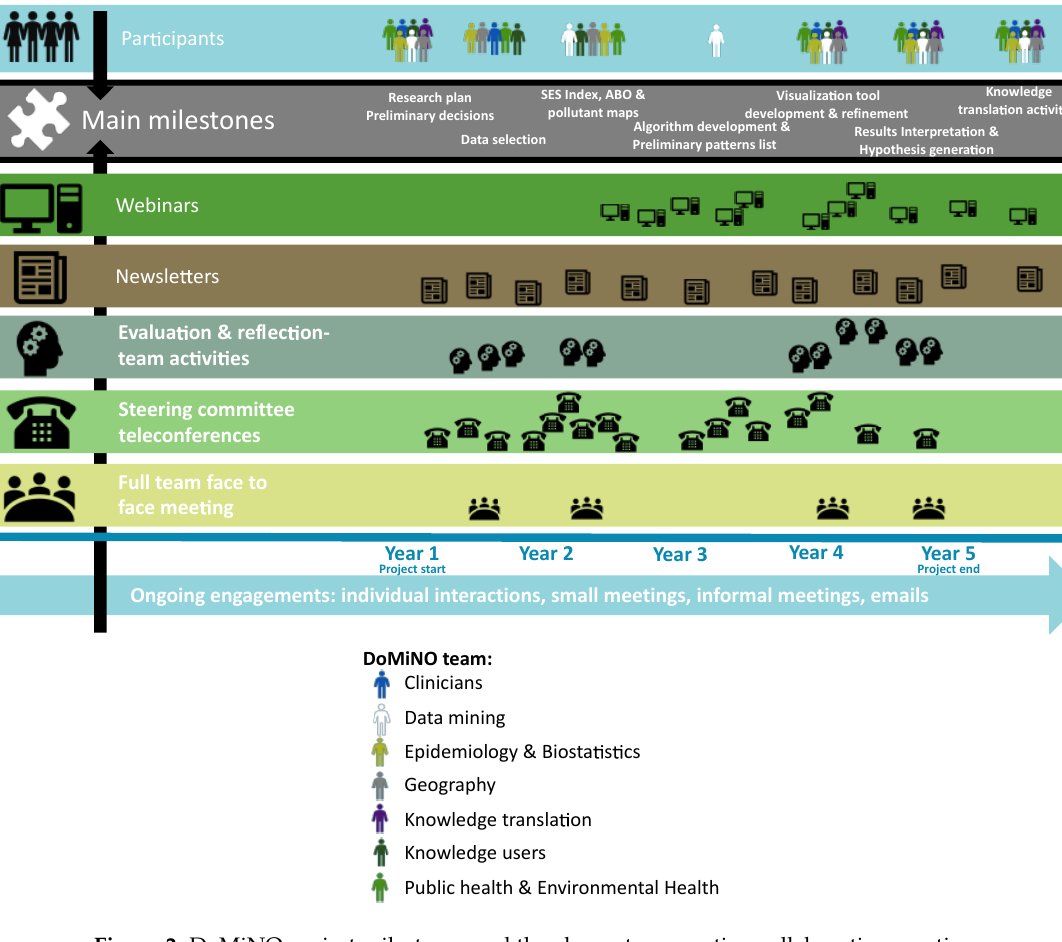
Figure 2. DoMiNO project milestones and the elements promoting collaborative practice .